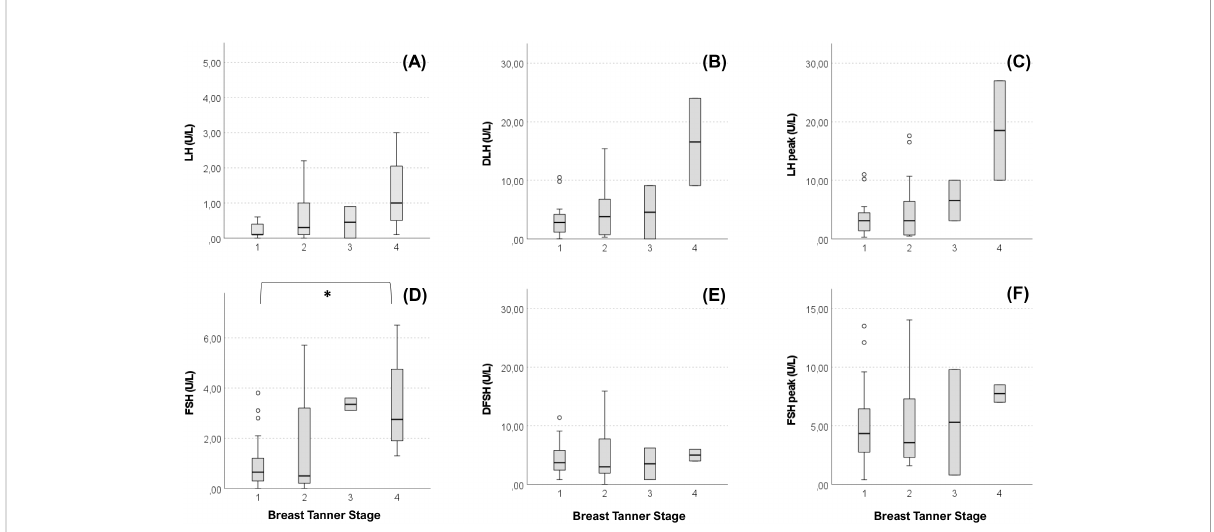
FIGURE 8 Basal and stimulated values of gonadotropins according Breast Tanner Stage. Value of basal LH (A) , difference between basal LH and LH peak (DLH) after stimulation test (B) , LH peak after stimulation test (C) , basal FSH (D) , difference between basal FSH and FSH peak (DFSH) after stimulation test (E) , FSH peak after stimulation test (F) compared according to Breast Tanner Stage. Pairwise comparison: * P =